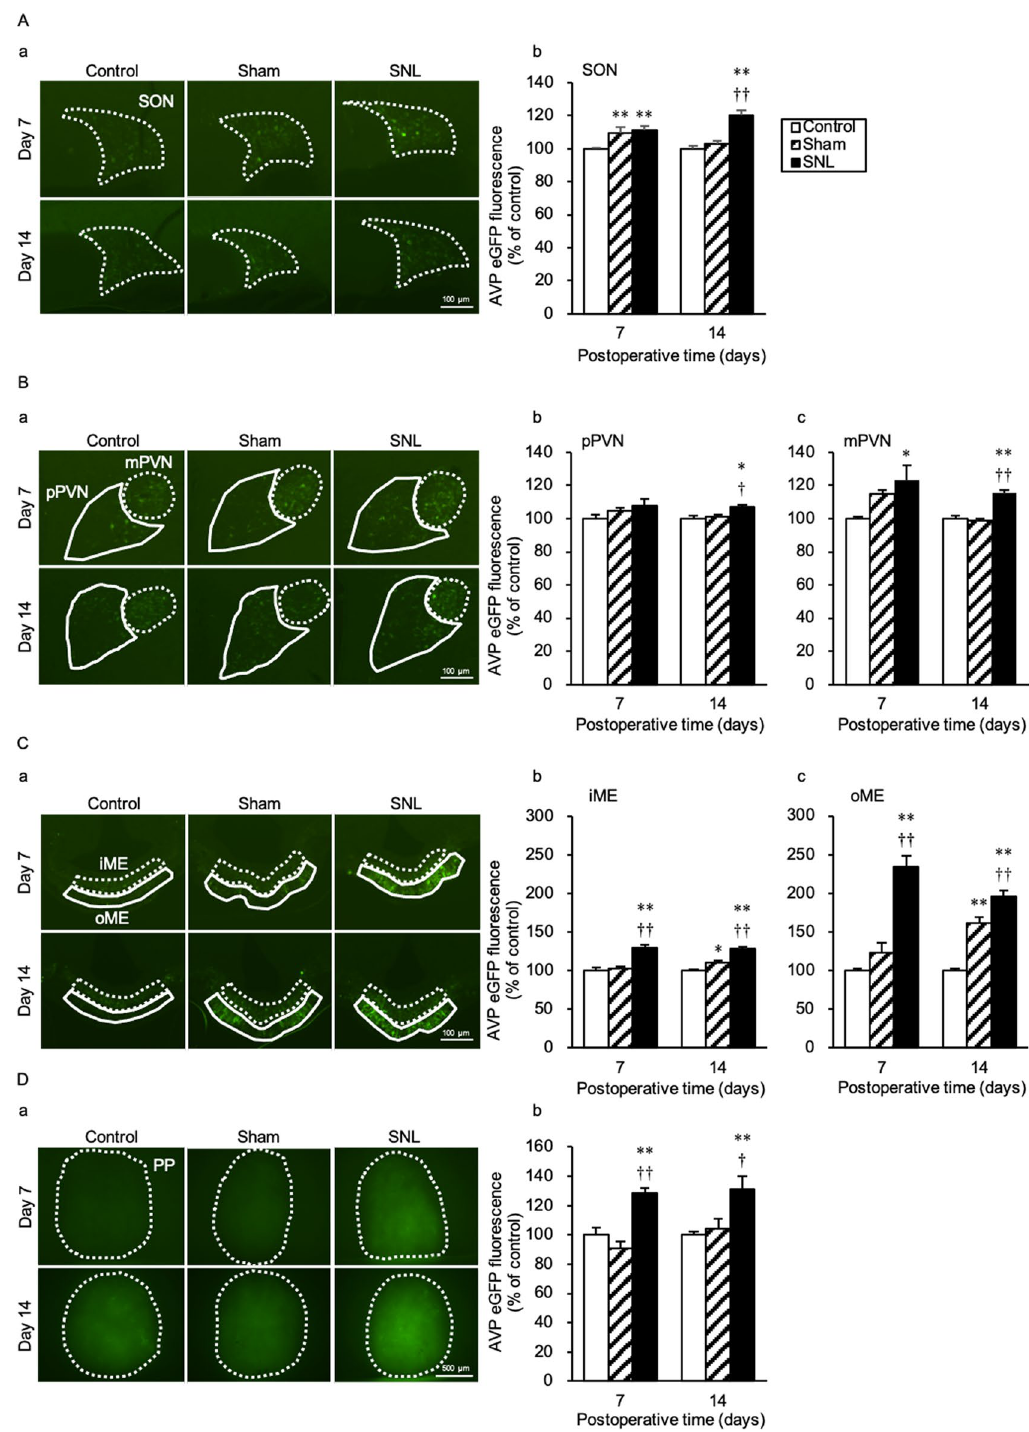
Figure 2. SNL increases intensities of AVP-eGFP fluorescence in SON, PVN, ME, and PP at day 7 and 14 after SNL. ( A ) ( a ) Fluorescence microscopic images of arginine vasopressin (AVP)-enhanced green fluorescent protein (eGFP) in the supraoptic nucleus (SON), where the region surrounded by a white dotted line indicates the SON. ( b ) Average eGFP fluorescence intensities of the SON. ( B ) ( a ) Fluorescence microscopic images of AVP-eGFP in the paraventricular nucleus (PVN), where the regions surrounded by the white dotted line and a white solid line indicate the parvocellular PVN (pPVN) and magnocellular PVN (mPVN), respectively. Average eGFP fluorescence intensities of ( b ) the pPVN and ( c ) mPVN. ( C ) ( a ) Fluorescence microscopic images of AVP-eGFP in the median eminence (ME), where the regions surrounded by a white dotted line and a white solid line indicate the inner ME (iME) and outer ME (oME), respectively; ( b ) and ( c ) present the average eGFP fluorescence intensities of the iME and oME, respectively. ( D ) ( a ) Fluorescence microscopic images of AVP-eGFP in the posterior pituitary (PP), where the region surrounded by a white dotted line indicates the PP. ( b ) Average eGFP fluorescence intensities of the PP. Data are presented as the mean ± SEM (one-way ANOVA). n = 6 per group. * p < 0.05 and ** p < 0.01 compared with each Control experiment. † p < 0.05 and †† p < 0.01 compared with each Sham